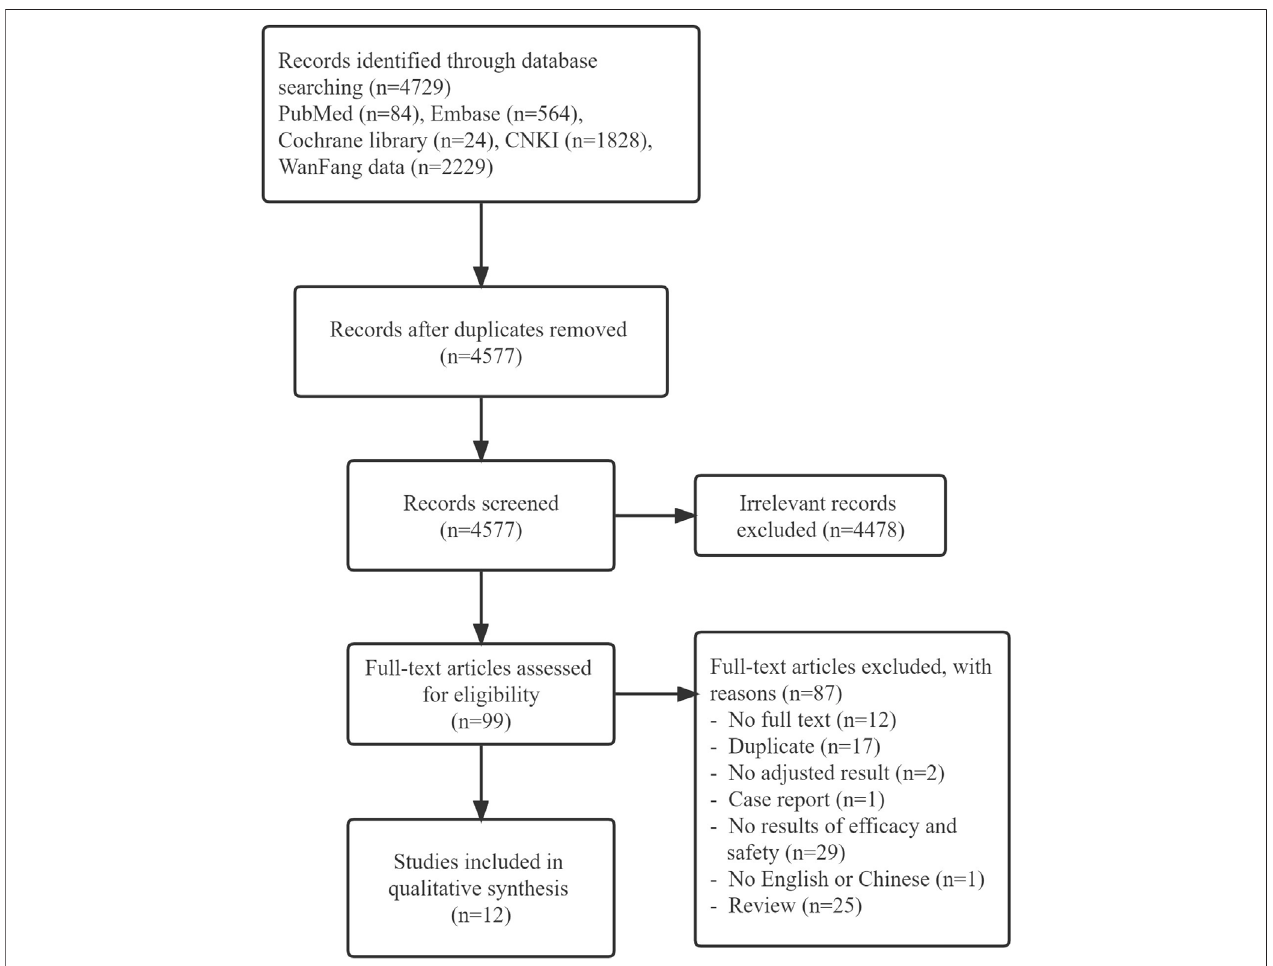
FIGURE 1 | Flow chart for the determination of included studies.